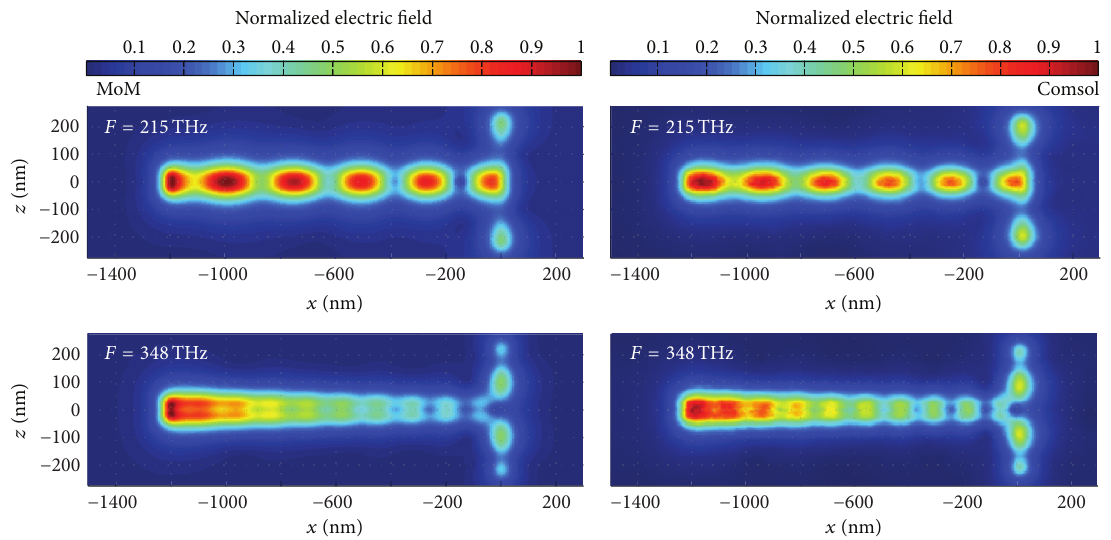
Figure 11: Normalized electric near field distributions at plane 𝑦 = 40 nm of nanocircuit at frequencies 𝐹 = 215 and 348 THz for cases with voltagereflectioncoefficient |Γ 𝑉 | = 0.77 and0.32,respectively.ParametersofMoMsimulationare ℎ = 210 nm, 𝐿 = 1200 nm, 𝑎 𝐿 = 𝑎 ℎ = 10 nm, = 10 , 𝑁 = 40 , Δ𝐿 = 30 nm, Δ𝐿 = 21 nm, 𝑁 = 102 , and processing time 3 min. Parameters of Comsol simulation are 𝑑 = 40 nm, 𝑁 ℎ 𝐿 𝐿 ℎ total number of elements: 713095, minimum mesh size of the conductors: 2.55 nm, minimum mesh size of spherical domain: 30.6 nm, and processing time: 5